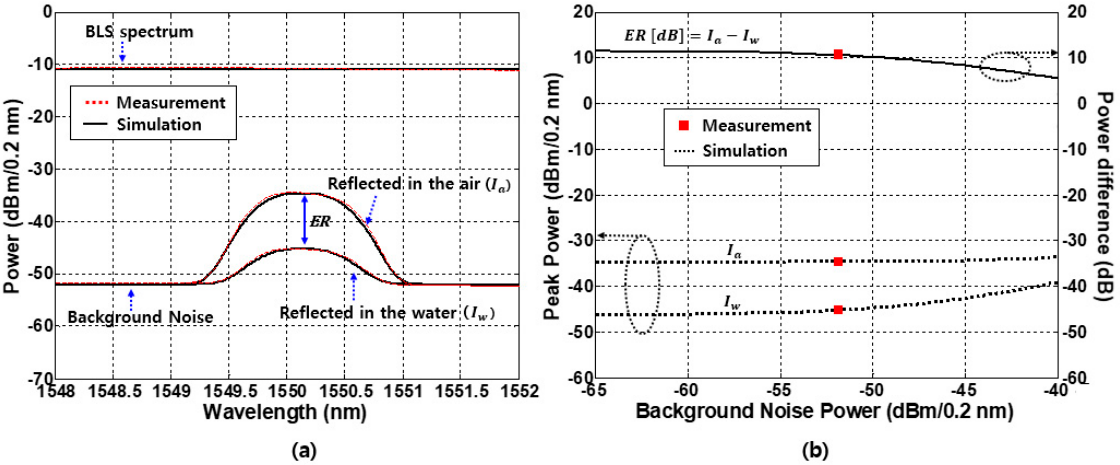
Figure 3. Fresnel reflection powers in the air and water. ( a ) Measured and simulated optical spectra for a single channel. ( b ) The value of 𝐸𝑅 according to the background noise power.